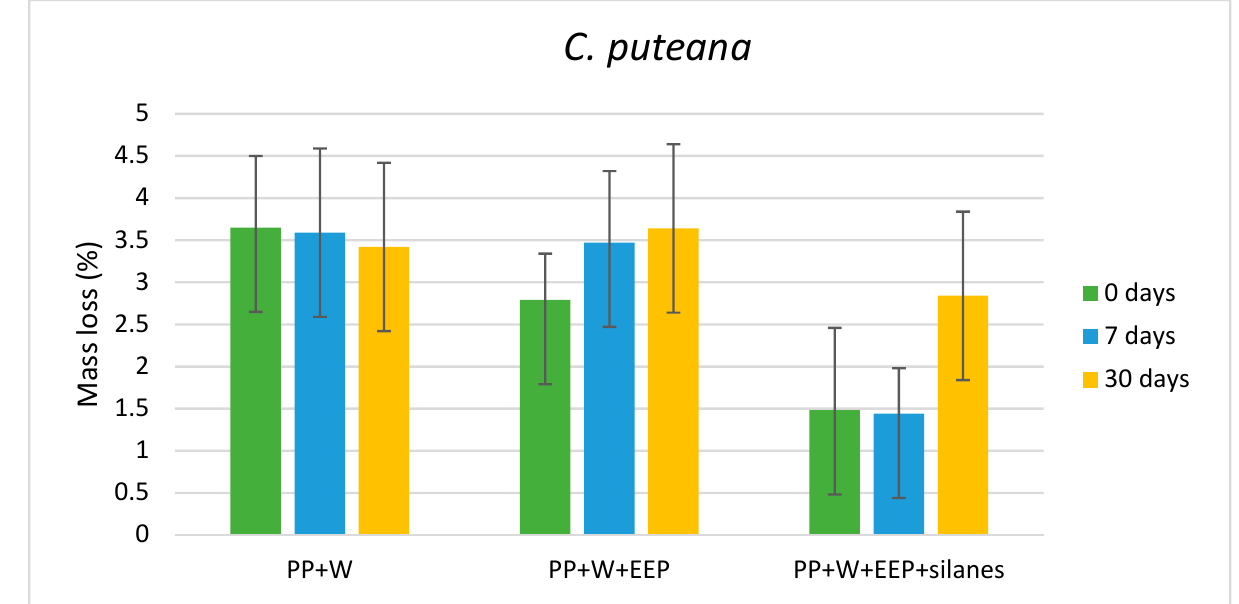
Figure 2. Mass loss of composites after exposure to C. puteana .